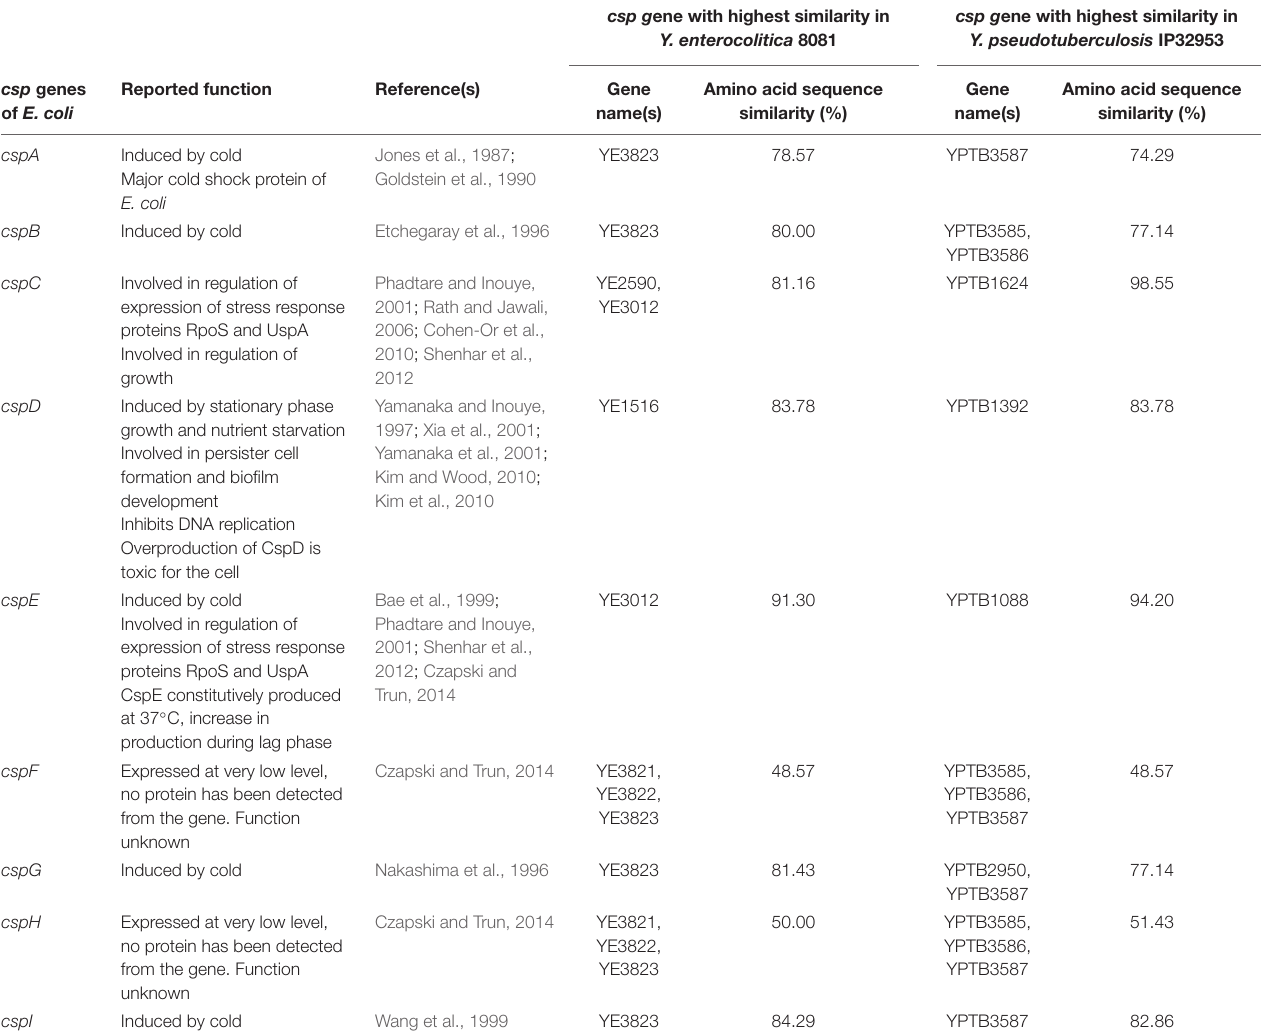
csp g ene with highest similarity in Y. enterocolitica 8081 Y. pseudotuberculosis IP32953